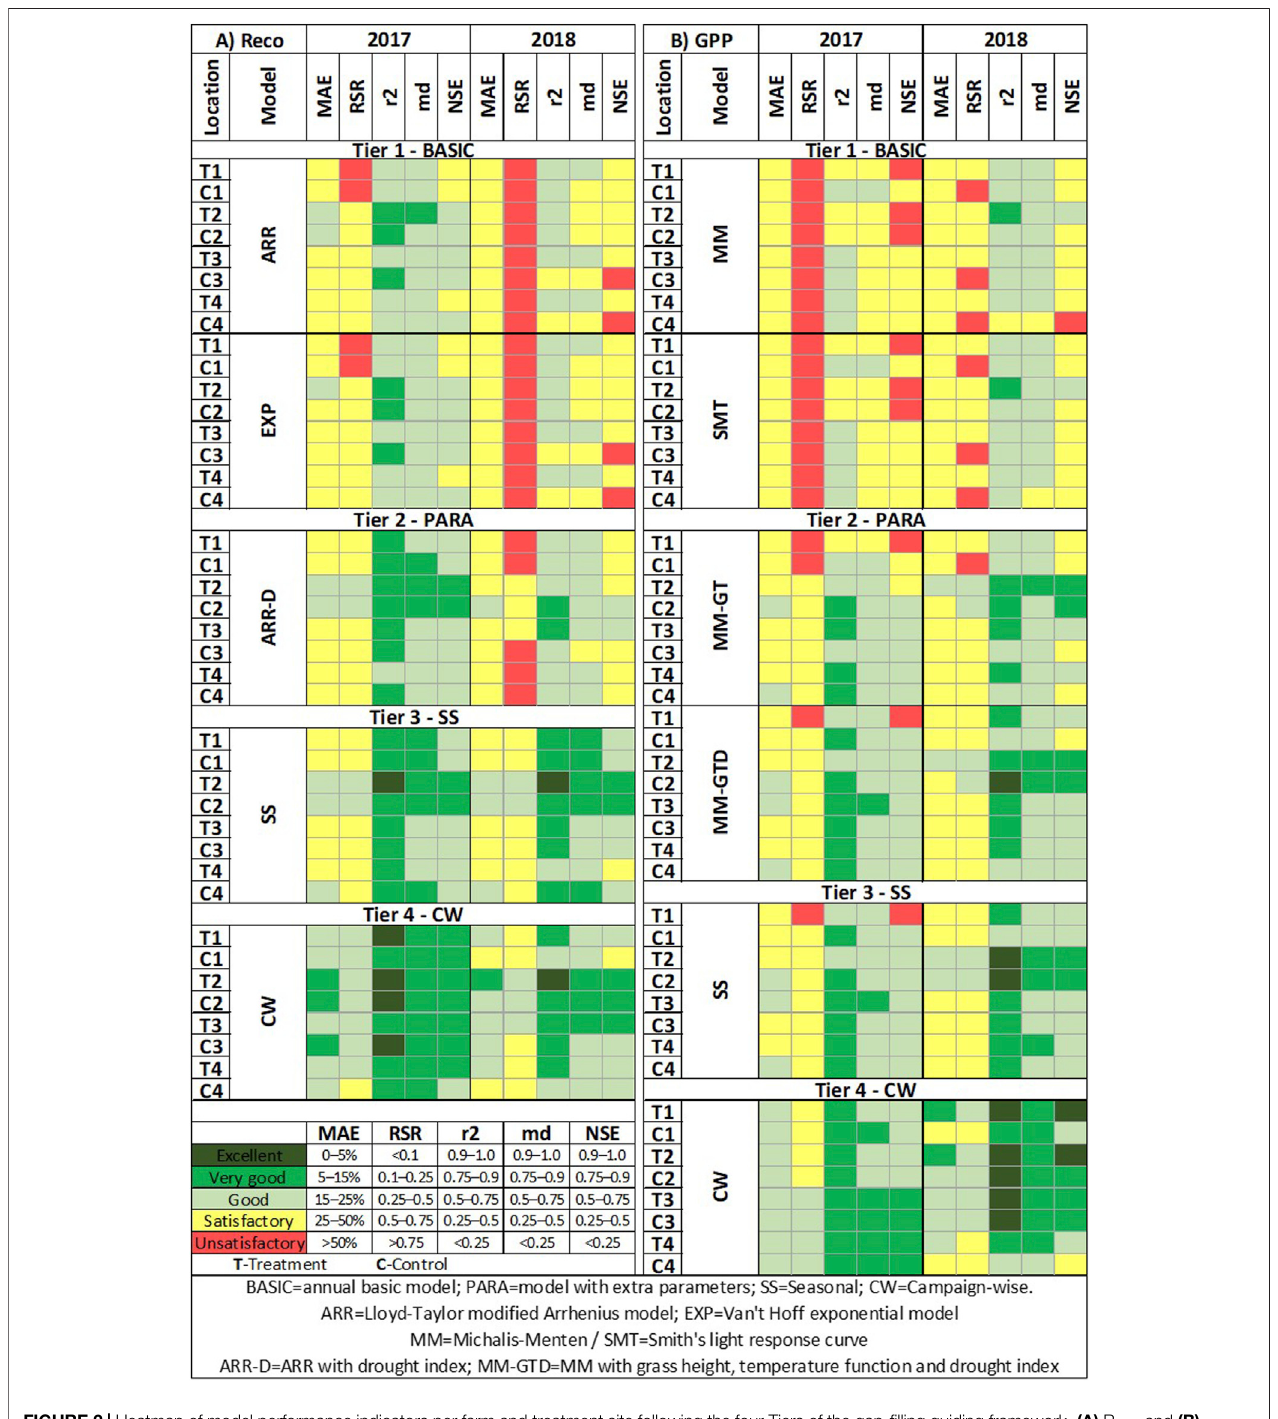
FIGURE 2 | Heatmap of model performance indicators per farm and treatment site following the four Tiers of the gap- fi lling guiding framework. (A) R eco , and (B) GPP. Statistical quality criteria were adopted from Moriasi et al. (2007) as used by Hoffmann et al. (2015): MAE = mean absolute error, RSR = root mean square error (RMSE)-observations standard deviation ratio, r 2 = coef fi cient of determination, md = modi fi ed index of agreement, NSE = Nash-Sutcliff model ef fi ciency.